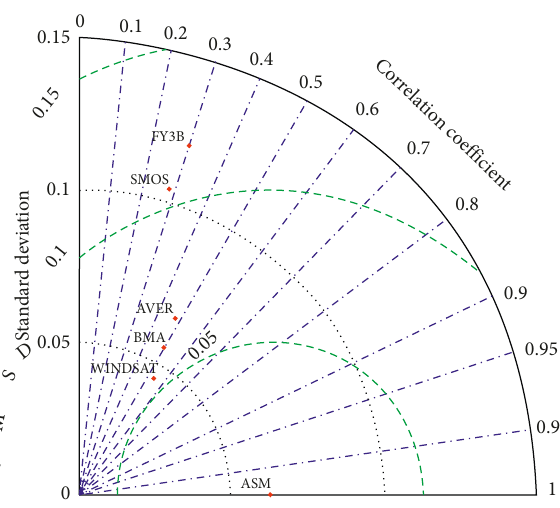
Figure 4: Taylor diagram for northern North China.